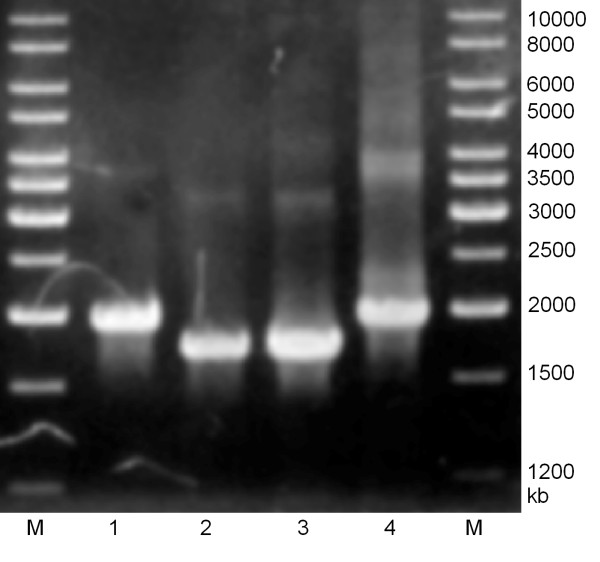
Amplification of thermostable lipase gene. M: Marker; 1: Control recombinant plasmid harboring thermostable lipase gene; 2: DSM 5366T; 3: DSM 7263T; 4: T1T.